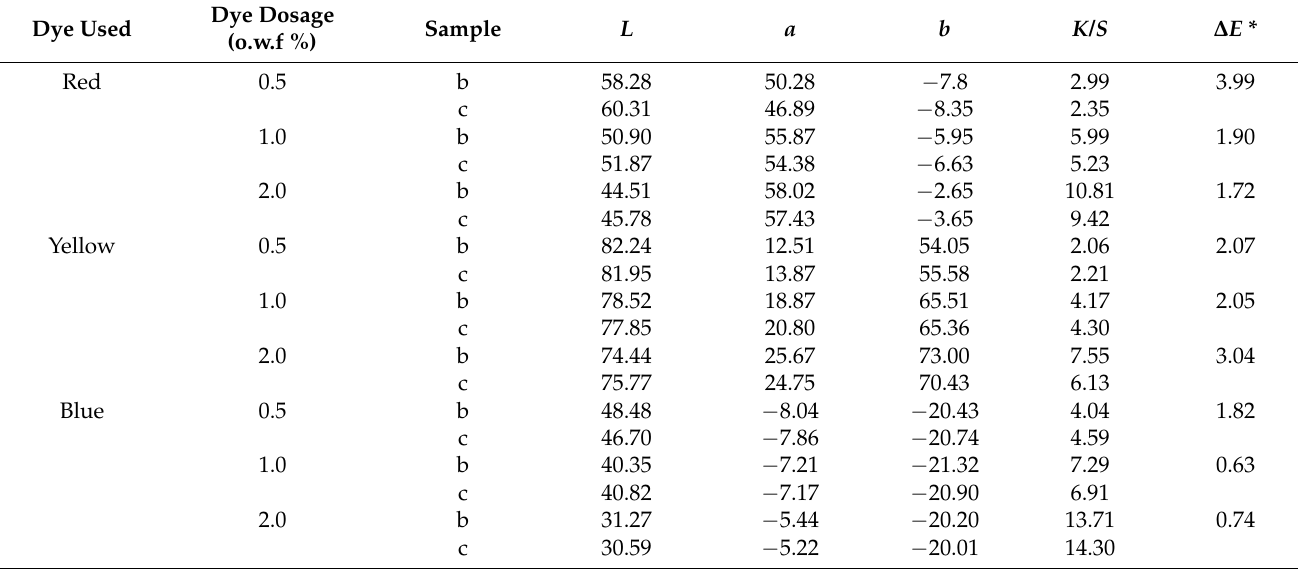
Table 3. Color characteristics of the dyed cotton